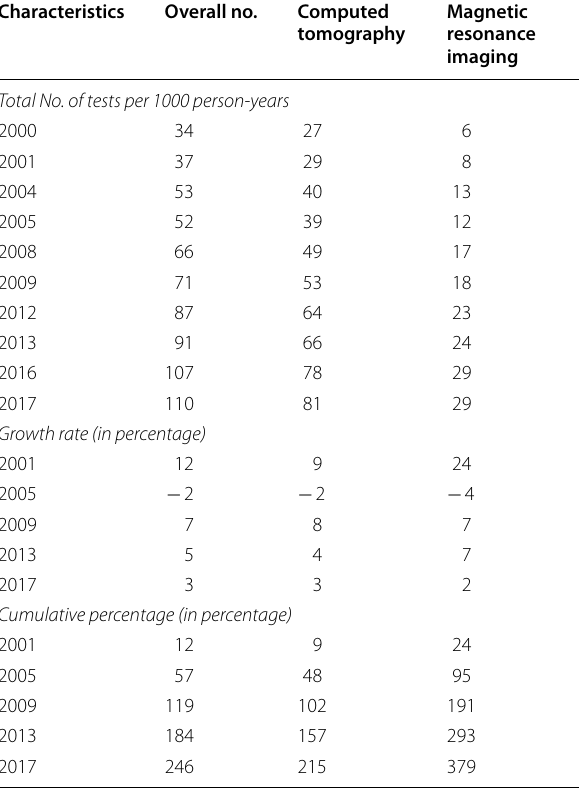
Table 1 Medical imaging utilization in Taiwan from 2000 to 2017 Characteristics Overall